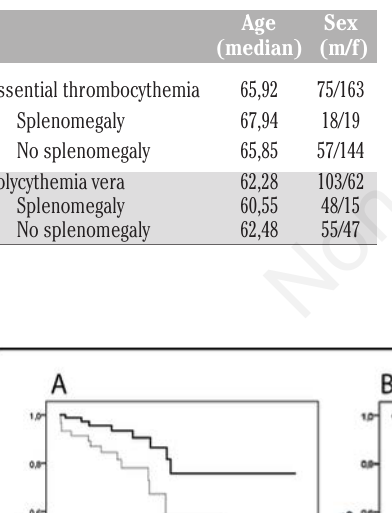
Table 1. Age and sex in patients with myeloproliferative disease with or without splenomegaly.